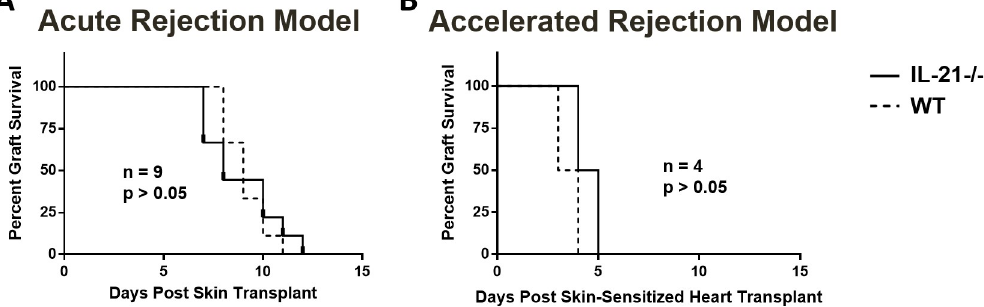
Fig 1. Graft survival in acute and accelerated rejection models. Graft survival over time in WT and IL-21-/- recipient mice of skin transplants from BALB/c donors (A) and BALB/c heart transplants after pre-sensitization with BALB/c skin transplants (B). Significance was calculated by Mantel-Cox